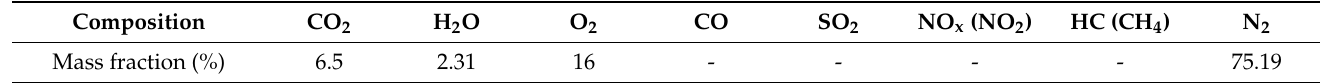
Table 3. Exhaust gas composition.